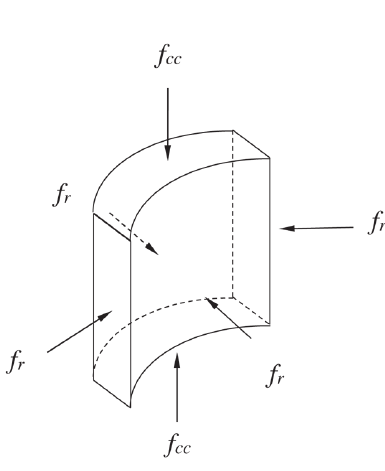
Fig. 3(c). Free body diagram of the core